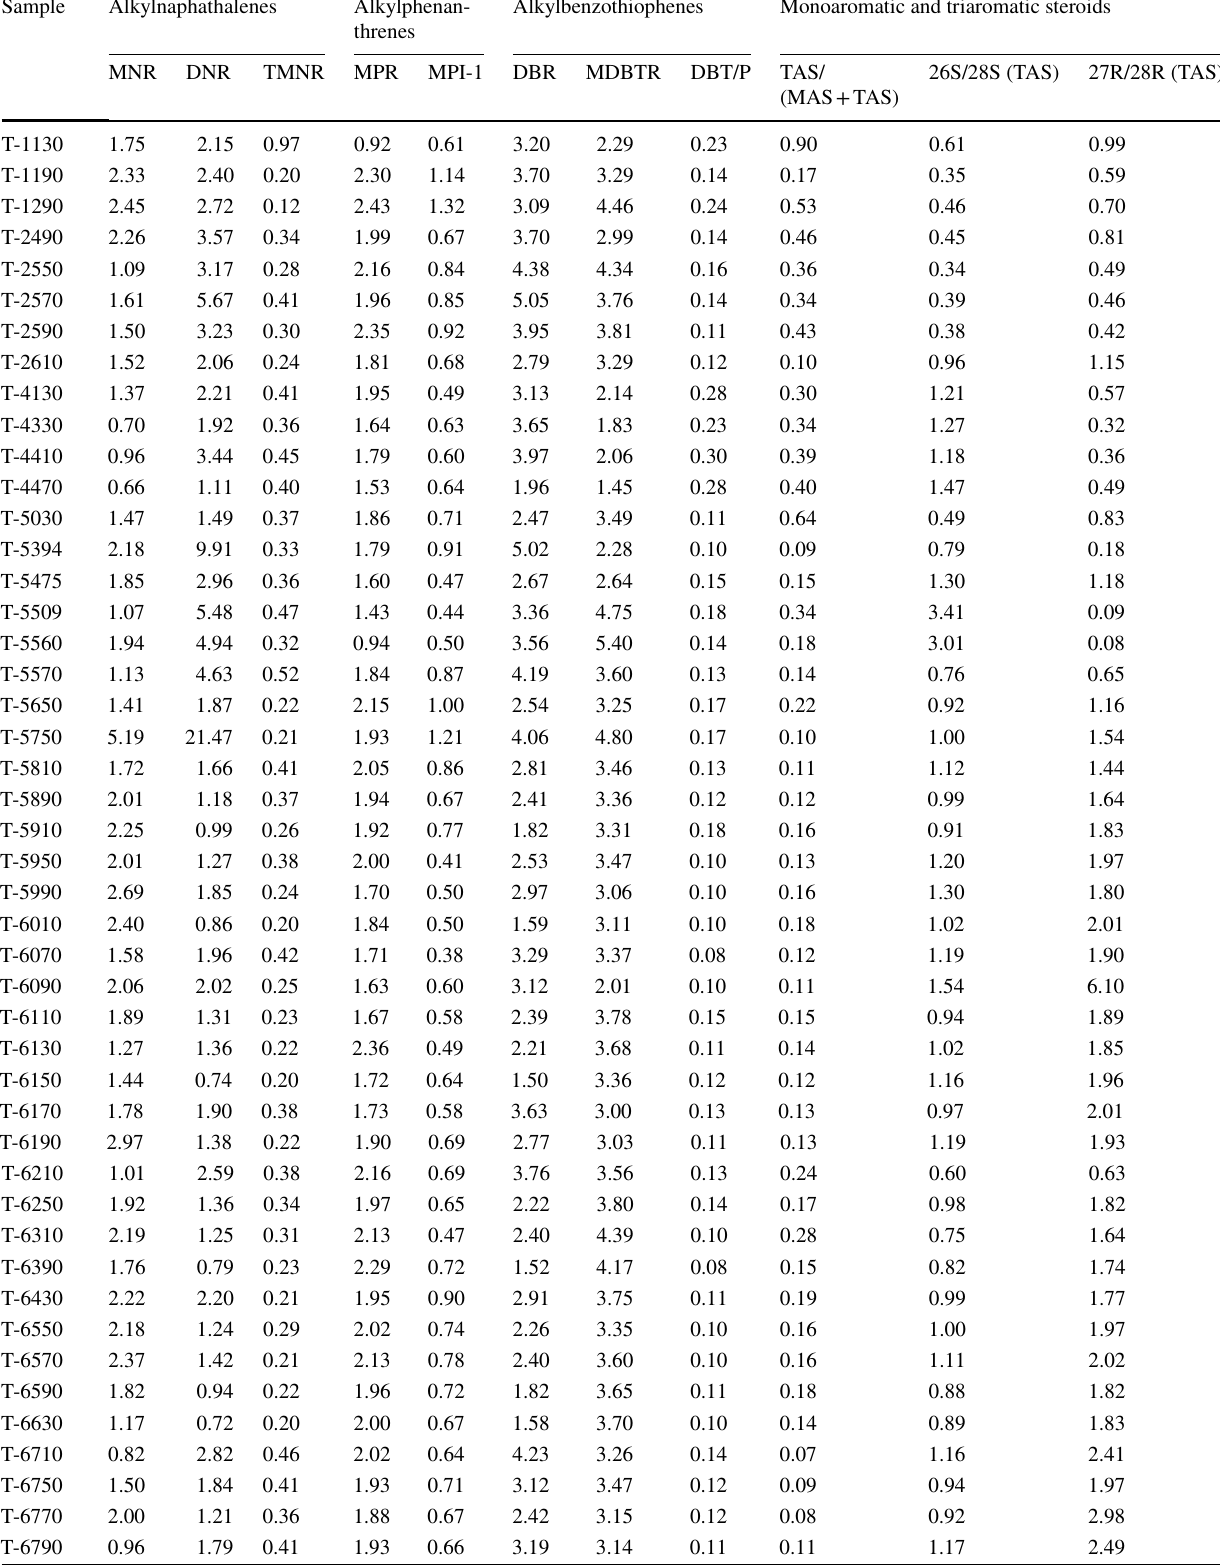
Table 4 Geochemical ratios based on Aromatic Hydrocarbons in organic extracts from rocks and cuttings in Tumaco-1-ST-P, Tumaco basin, Colombia Sample